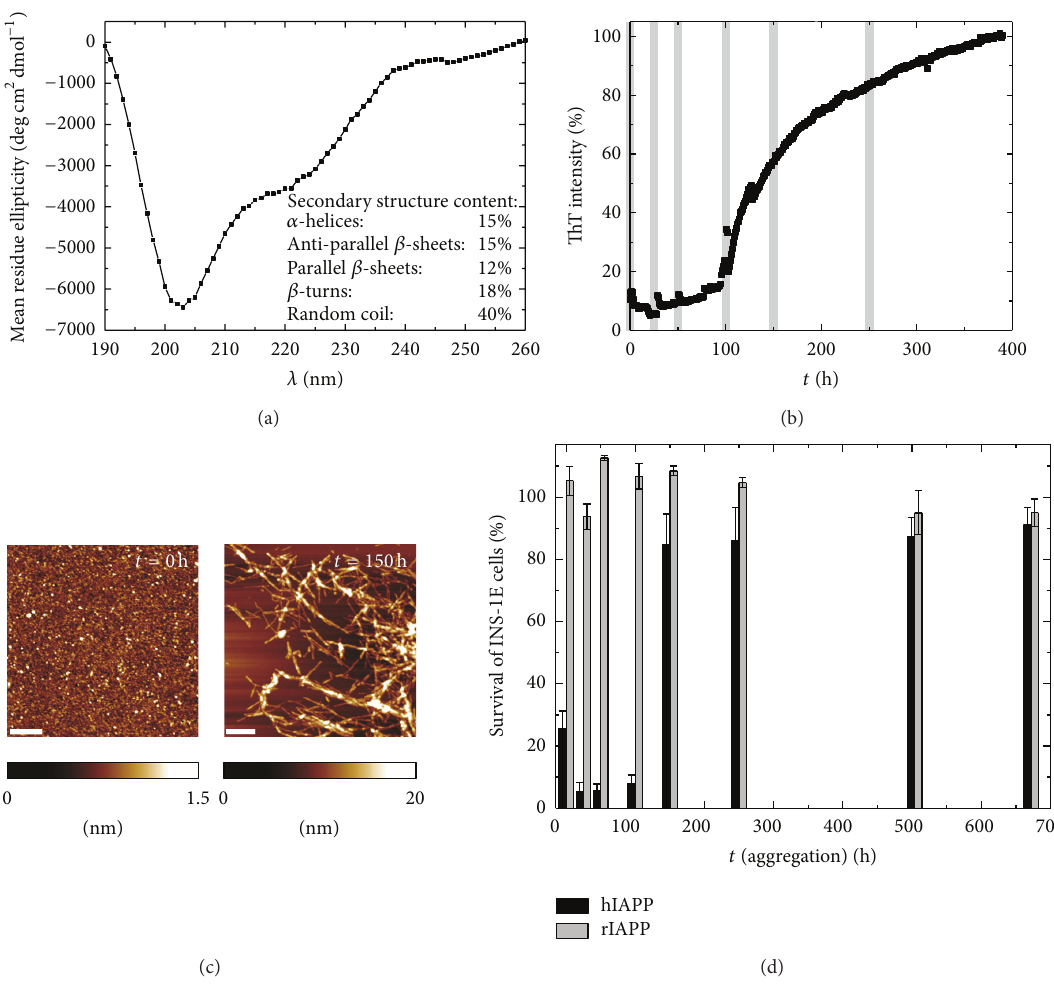
Figure 3: Structure, morphology, and cytotoxicity of hIAPP during its self-assembly. (a) CD spectrum of freshly prepared hIAPP (10 𝜇 M) in 10mM phosphate buffer, pH 7.4 at 25 ∘ C, and secondary structure content obtained indicating a predominantly disordered structure of the monomeric peptide. (b) ThT assay of 100 𝜇 M hIAPP in 10mM sodium acetate buffer containing 50 𝜇 M ThT, at pH 5.5, and 10 ∘ C showing a sigmoidal curve typical for a nucleation-dependent process. The fluorescence intensity was normalized to the intensity recorded at 400 h assuming the fibril formation to be completed. Time points at which hIAPP species were isolated are highlighted in gray. (c) Tapping mode AFM images of isolated hIAPP species at particular time points of the aggregation process showing the hIAPP morphology within the lag phase and the elongation phase. The scale bar included in the images represents 250 nm. (d) WST-1 cell proliferation assay of pancreatic INS-1E cells exposed to 10 𝜇 M isolated hIAPP and nonamyloidogenic ratIAPP species at different time points of the aggregation process, indicating the highest toxicity of hIAPP species within the lag phase. Adapted and modified from [17, 56] with permission from Wiley-VCH and